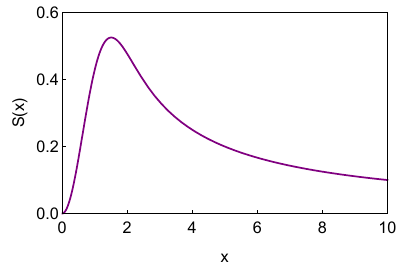
Figure 3 . Plot of the function